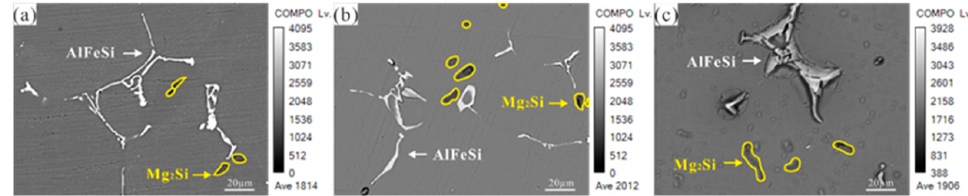
Figure 9. ( a ) SEM analyses of corrosion morphology after the corrosion products were removed obtained by immersion in 3.5% NaCl solution after 168 h; ( b ) EDX elemental maps of ( a ).